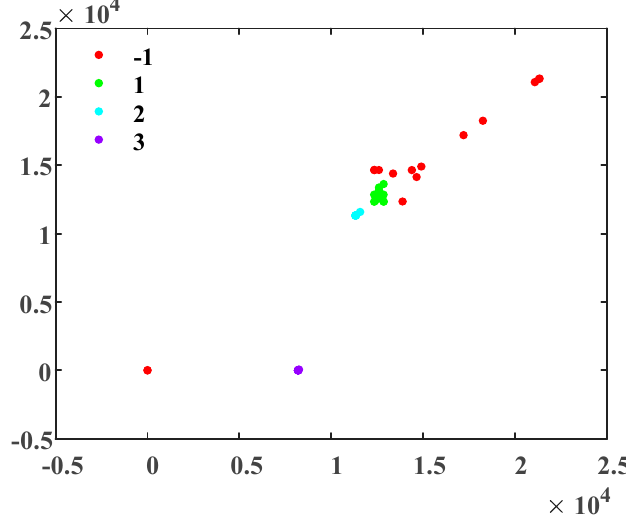
Figure 25. The DBSCAN clustering results for I L and I R .